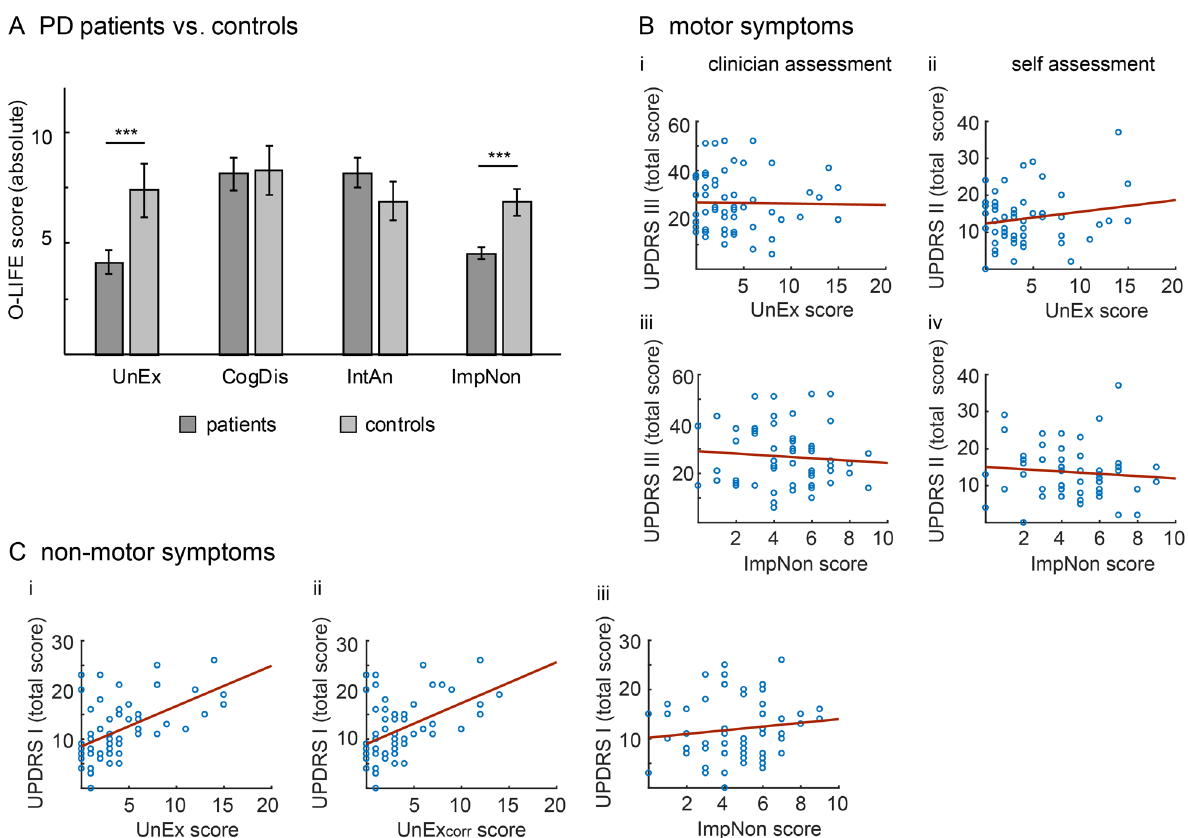
Figure 1. Schizotypy in PD patients compared to controls. ( A ) Mean (± standard error) absolute values of O-LIFE subscores across PD patients and healthy controls. PD patients exhibit lower positive schizotypy than age-matched healthy controls. Results of two-sided Wilcoxon signed rank tests are indicated: ***p < 0.001. ( B ) UnEx and ImpNon scores did not correlate with motor impairment rated by clinicians (UPDRS III; Bi and Biii) or by patients themselves (UPDRS II; Bii and Biv). Blue dots illustrate data from individual patients. ( C ) Illustration of non-motor impairment in PD patients as a function of original (UnEx) and corrected UnEx scores (UnEx corr ). UPDRS I scores correlated with UnEx (Ci) and UnEx corr (Cii), but not ImpNon scores